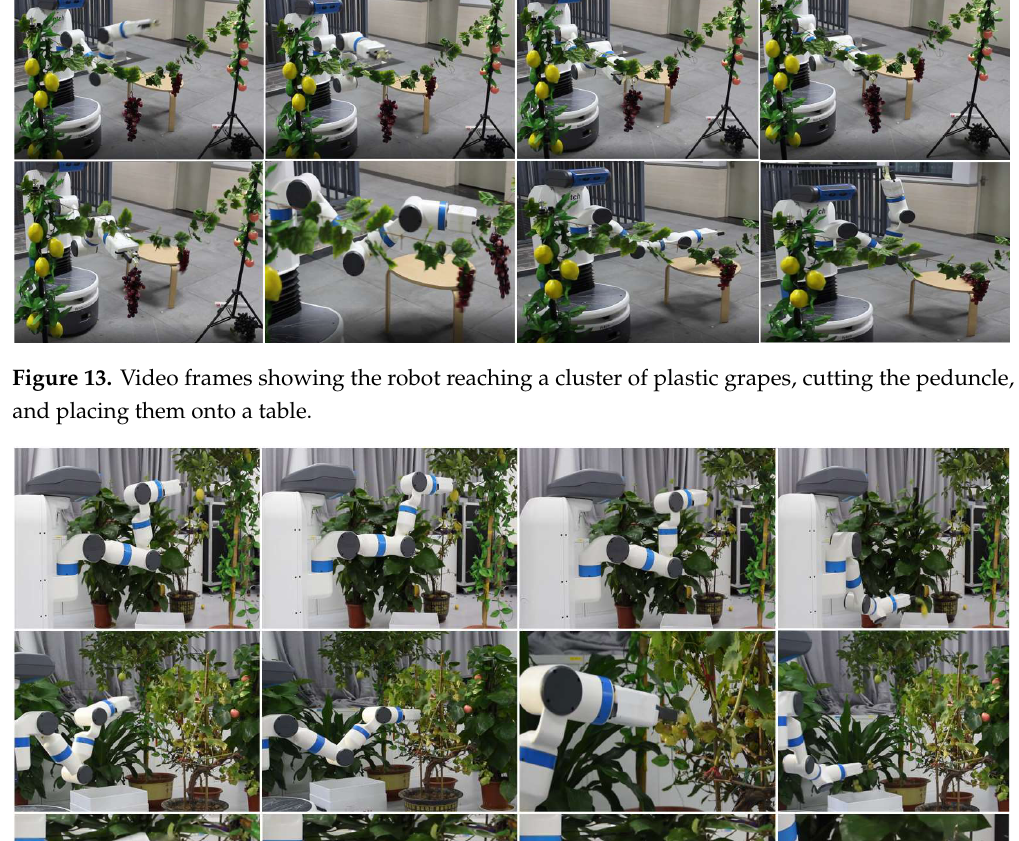
Figure 14. Video frames showing robot harvests real lemons (top), grapes (middle), and common figs (bottom).